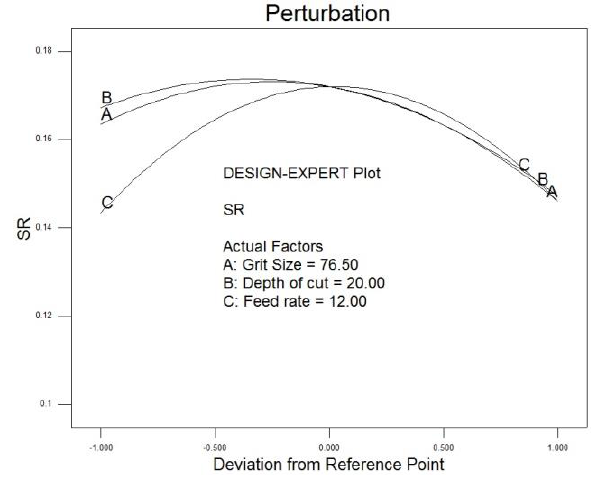
Figure 7: Individual effects of the process variables.